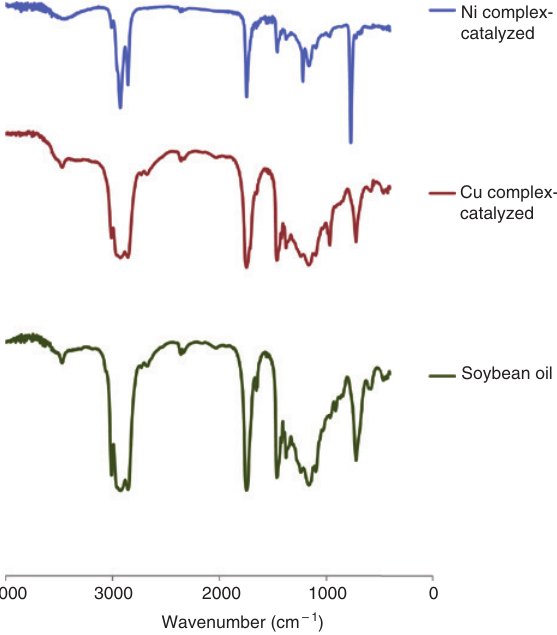
Figure 10: FT-IR spectra of non-polymerized and polymerized soybean oil by Ni and Cu complex